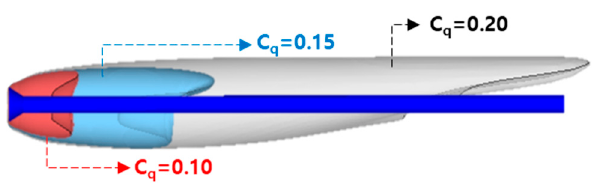
Figure 7. Cavitation formation at various ventilated rate coefficients.